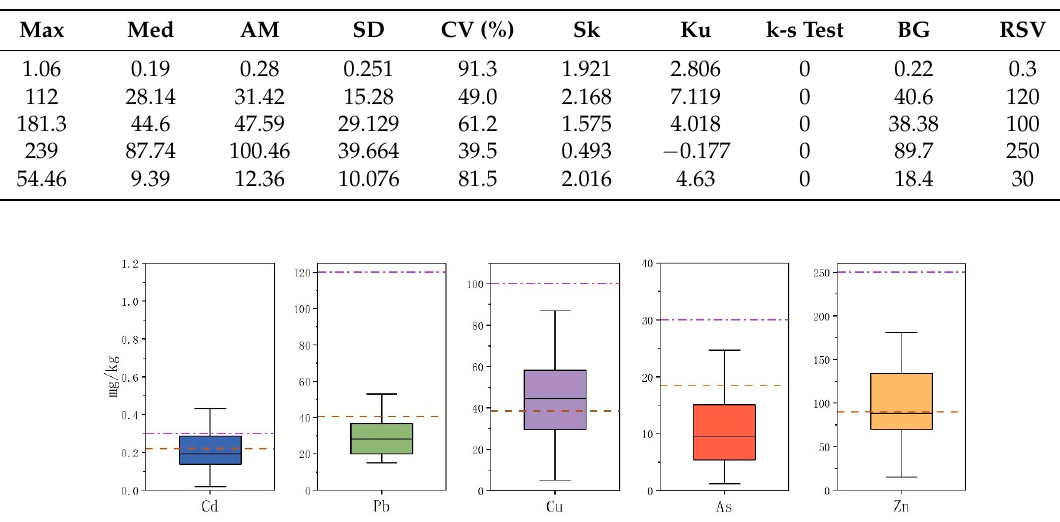
Table 4. Descriptive statistics of soil PTEs in the study area (mg/kg). Min = minimum value; Max = maximum value; Med = median value; AM = arithmetic mean; SD = standard deviation; CV = coef ‐ ficient of variation; Sk = skewness; Ku = kurtosis; k ‐ s test = Kolmogorov–Smirnov test; BG = back ‐ ground values of Yunnan Province (CNEMC, 1990); RSV = risk screening values of the soil PTEs (GB15618 ‐ 2018).